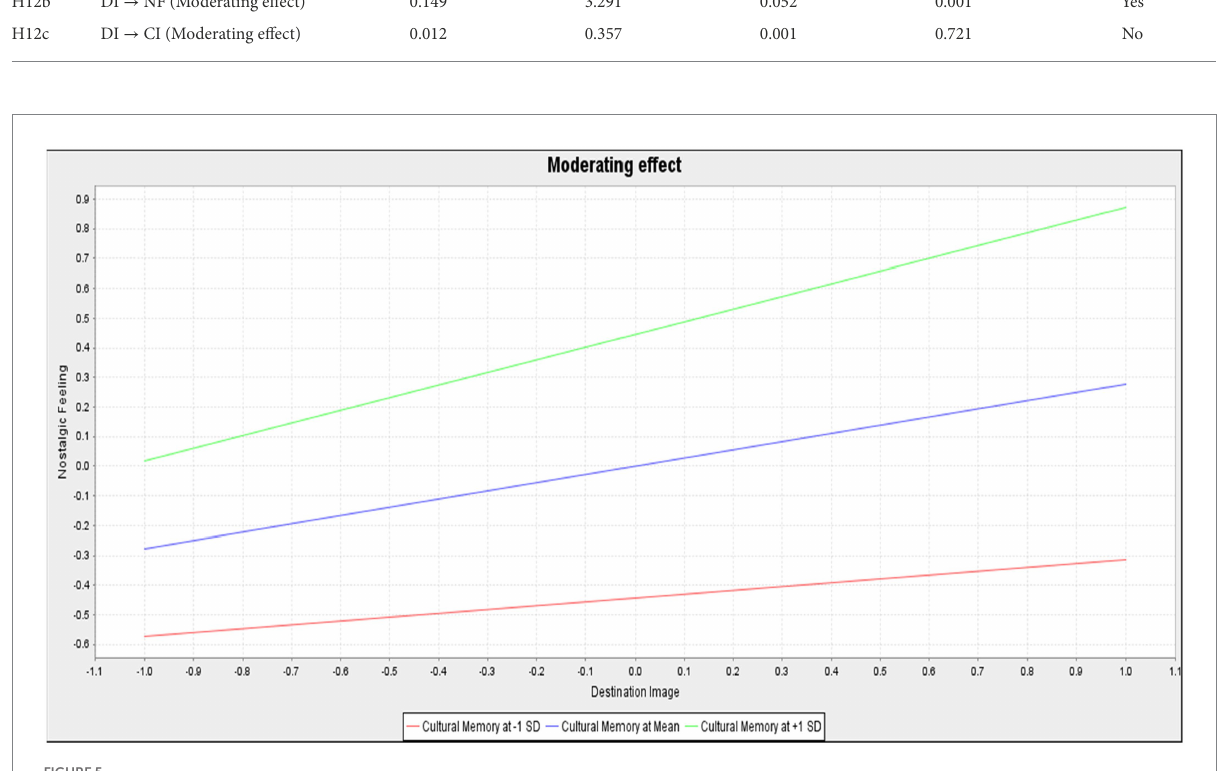
FIGURE 5 The moderating effect of cultural memory in destination image on